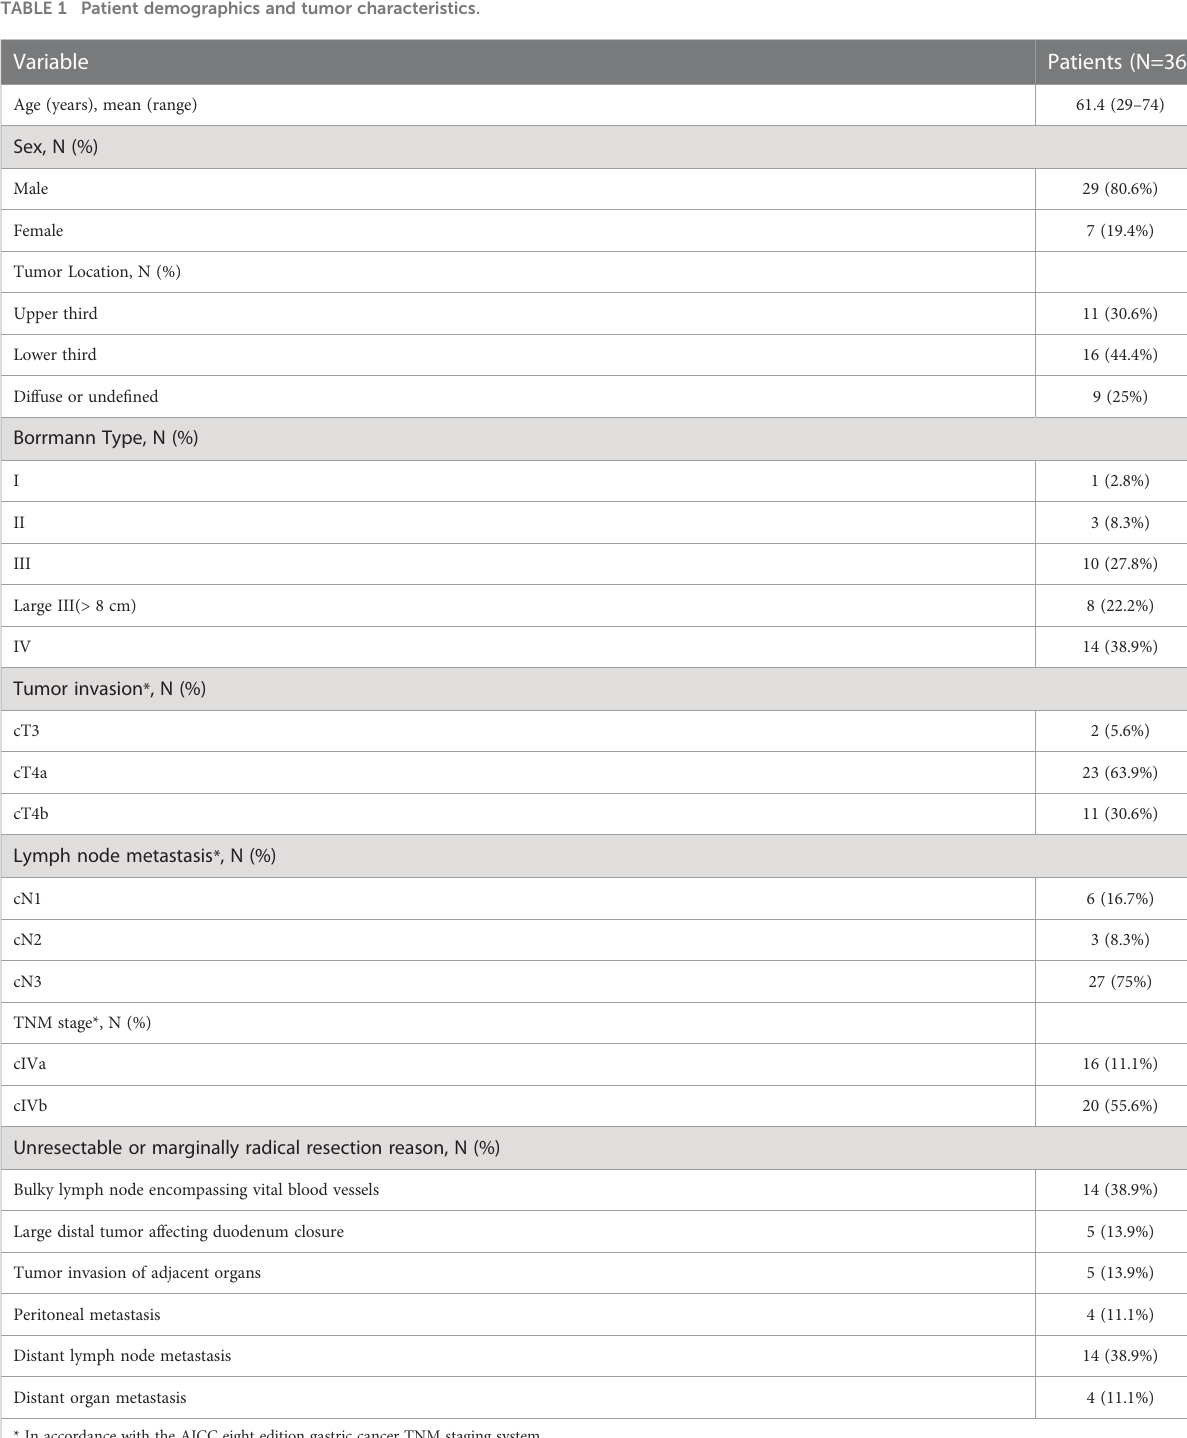
TABLE 1 Patient demographics and tumor characteristics.